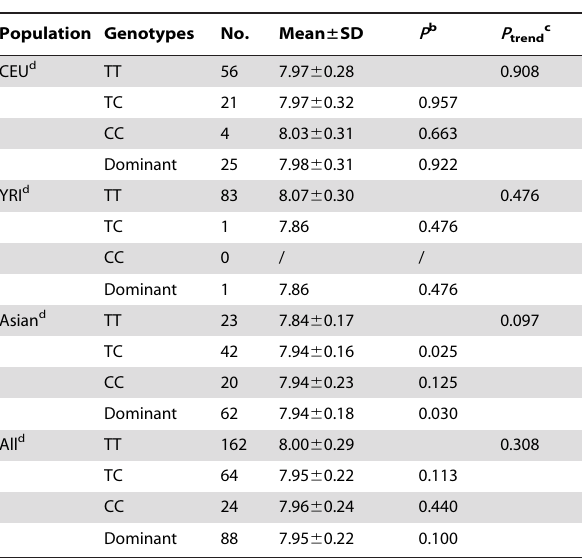
Table 4. PARP1 mRNA expression by the genotypes of rs1136410T . C (Val762Ala) a